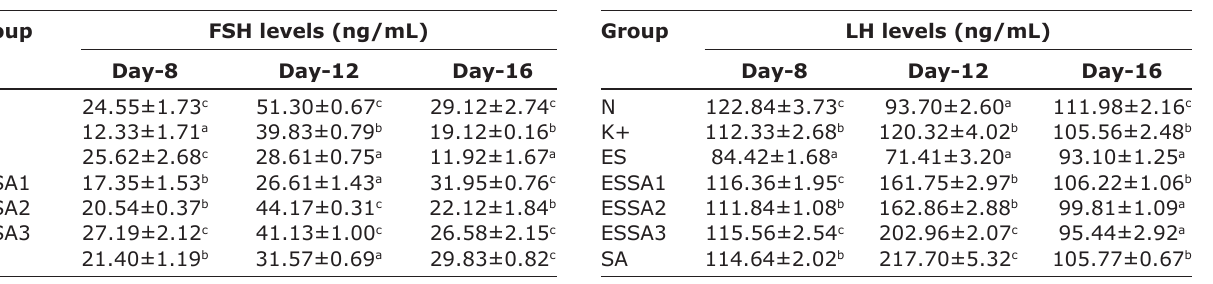
Table-2: Effect of combined ES and SA extract on LH levels of infected pregnant